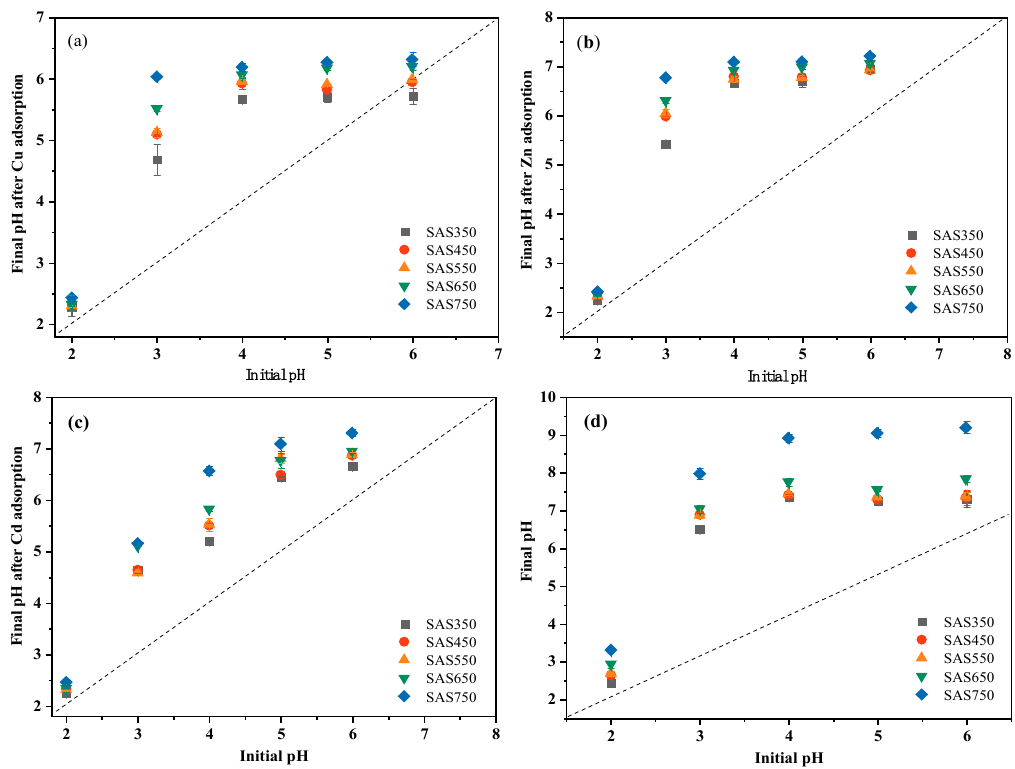
Figure 2. The pH changes of Cu(II) ( a ), Zn(II) ( b ), and Cd(II) ( c ) solutions after adsorption equilibrium, respectively. ( d ) Change of pH of solution without heavy metals after equilibrium.